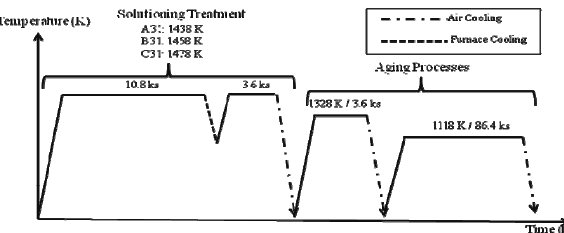
Figure 8. Simulated reheat treatment programs: A31, B31 and C31.